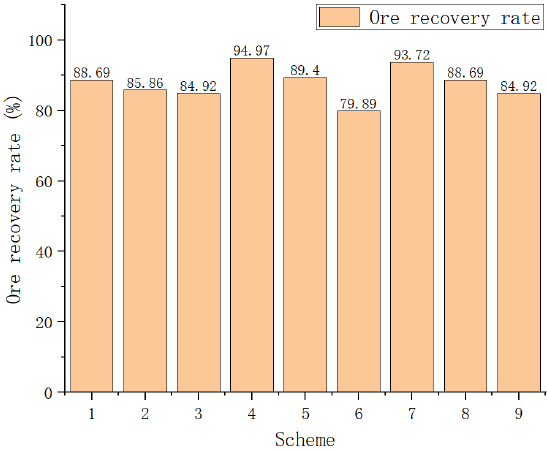
Figure 40. Designed ore recovery rate of schemes 1 to 9.